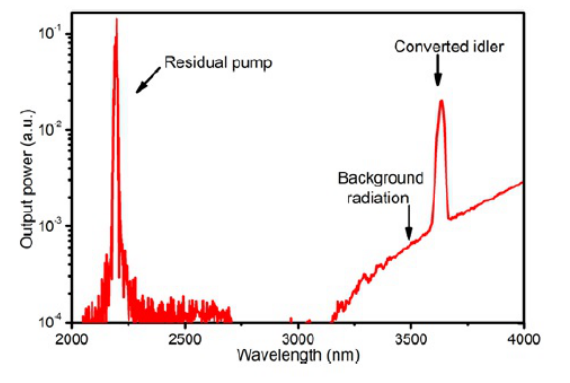
Fig. 19. The output spectrum of the wavelength translator when it is seeded with a CW probe at 1565 nm. A strong signal at 3635 nm can be seen above the thermal background of the detector. Adapted from reference [65].